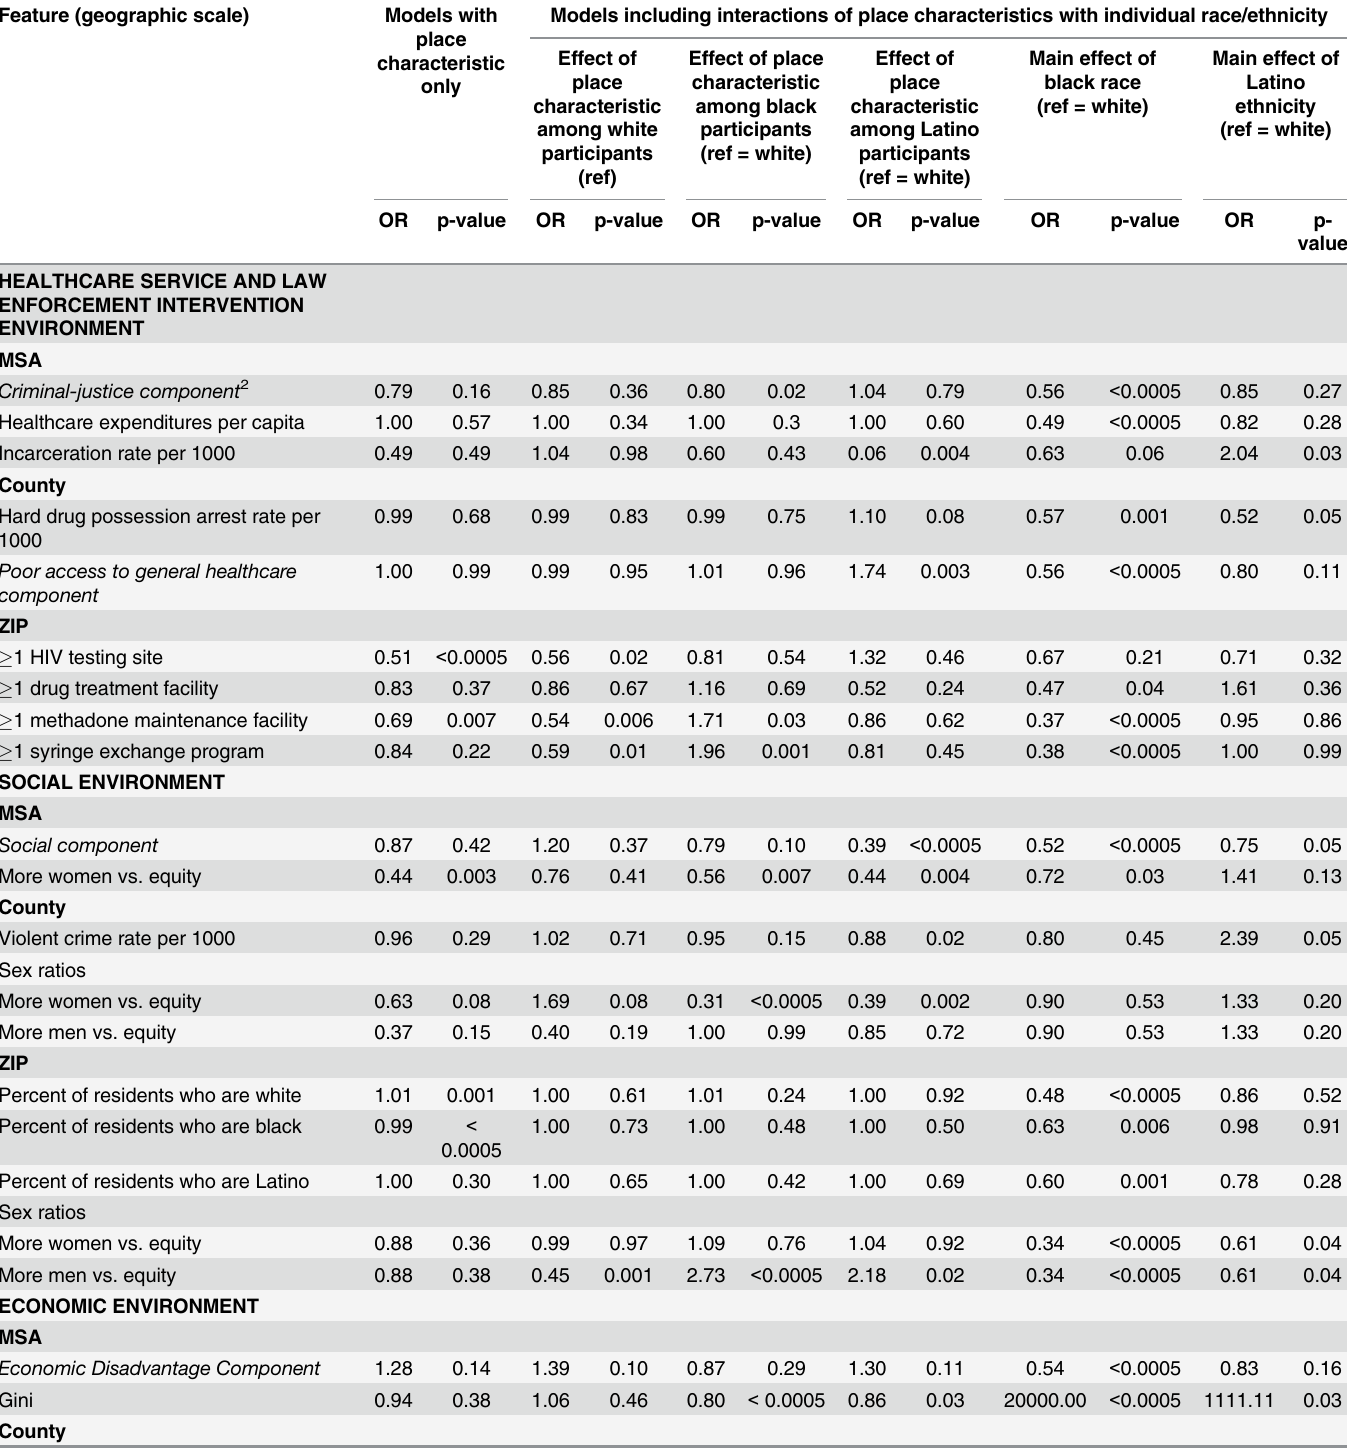
Table 5. Bivariate associations between HIV negative status and (a) features of the environments where people who inject drugs (N = 9,077) lived when participating in the 2009 National HIV Behavioral Surveillance, and (b) participant characteristics 1 . Place-based